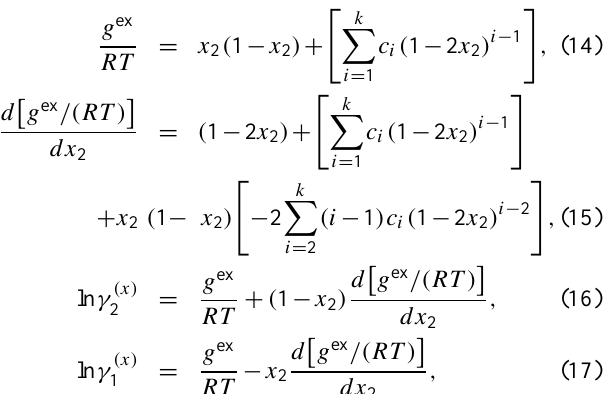
Fig. 2. Activity coefficient deviations 1 sc , sf γ (x) free vs. salt-containing mixtures in the water (1)+2-propanol (2)+LiCl (3) system derived from isobaric VLE data at 354–358K. Experimental data ( , ) by Lin et al. (1993) and calculated values ( , ) are shown in blue for water and in green for 2-propanol. The error bars represent the model sensitivity to a composition varia- tion by x tol = 0 . 01. The mixture compositions with respect to com- pletely dissociated LiCl are shown in the bar